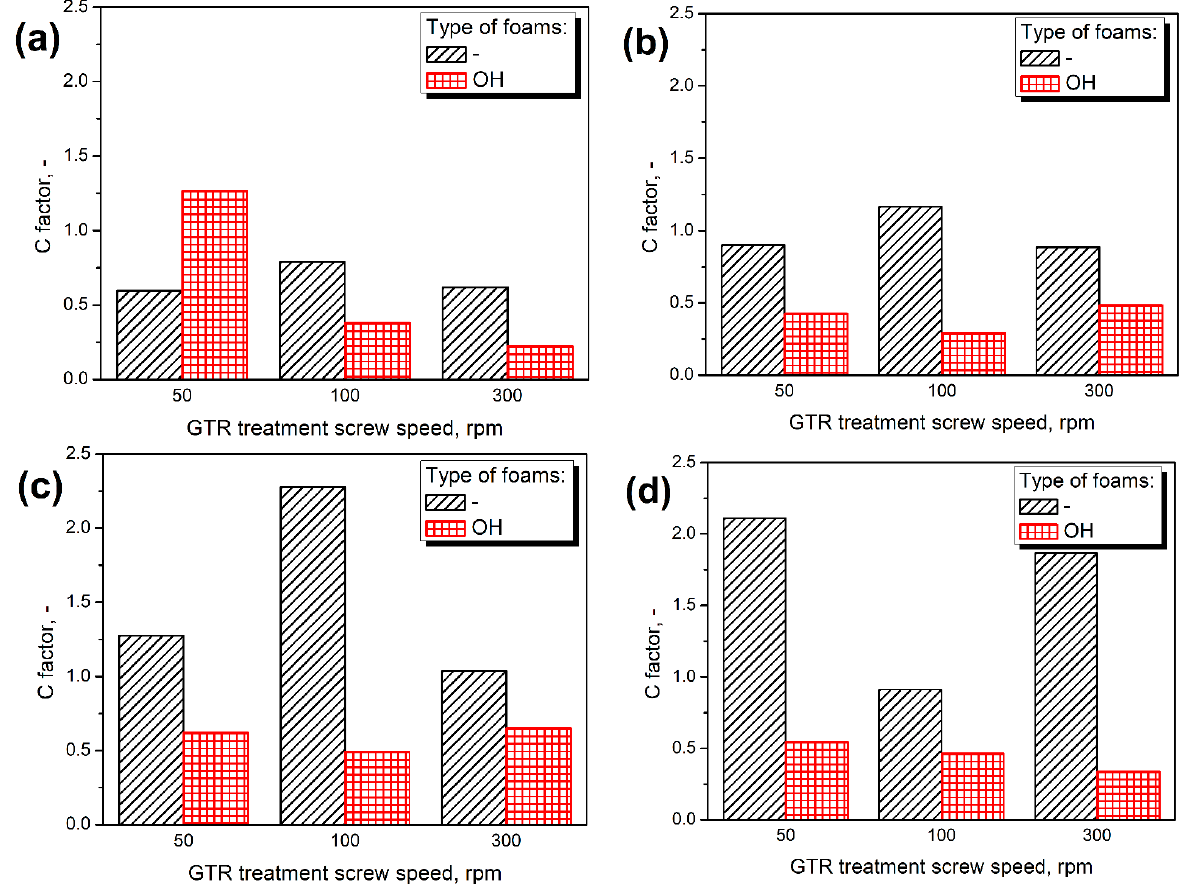
Figure 8. Values of C factor calculated for composites containing GTR modified at ( a ) 50 °C, ( b ) 100 °C, ( c ) 150 °C, and ( d ) 200 °C.